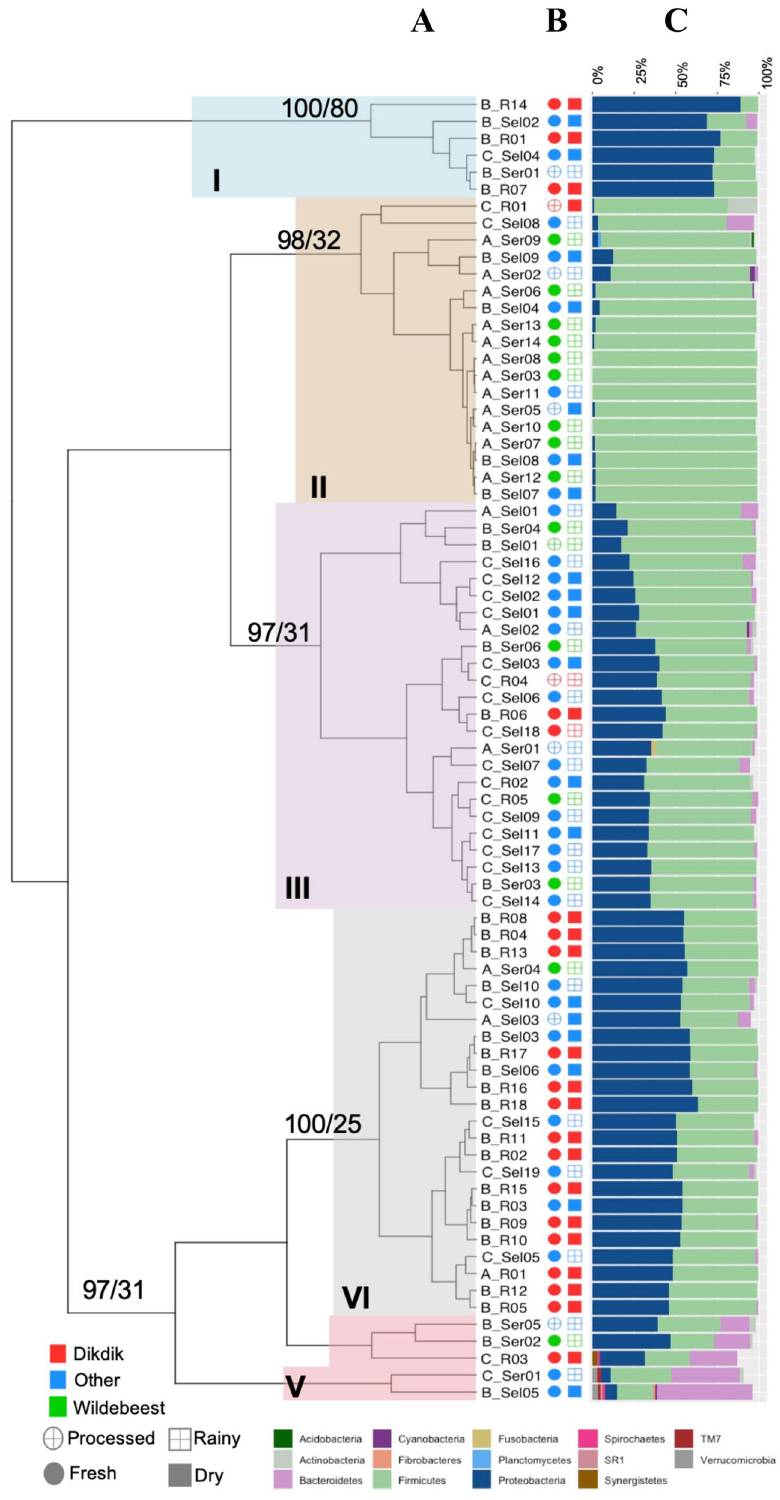
Figure 4. Hierarchical clustering of the samples positive for one of the three pathogens based on the relative abundance of phyla in each sample. ( A ) Hierarchical clustering of samples. The samples grouped into 5 clusters: I—blue, II—tan, III—purple, IV—grey, V— red. The samples are labeled with the first letter representing the pathogen (A— B. anthracis , B— Brucella , C— Coxiella ) and the ending representing the ecosystem (R—Ruaha, Sel—Selous, Ser—Serengeti). The AU/BP values for the clustering are shown at the base of each node. ( B ) Sample metadata. These columns show the other metadata associated with each sample. The open circles represent processed samples, and the closed are fresh samples. The open squares are from rainy season and the closed squares are from dry season. The shapes are colored according to species of wildlife from which the bushmeat originated: dik-dik—red, wildebeest—green, all other species—blue. ( C ) Bar graph of the relative abundance of phyla. The relative abundance of phyla > 1% is shown in the stacked bar graph. The colors corresponding to each respective phylum is in the legend at the